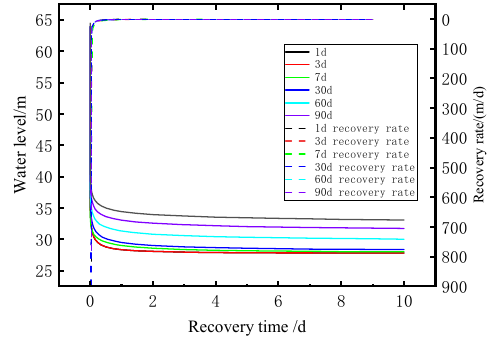
Figure 9. Water level recovery.